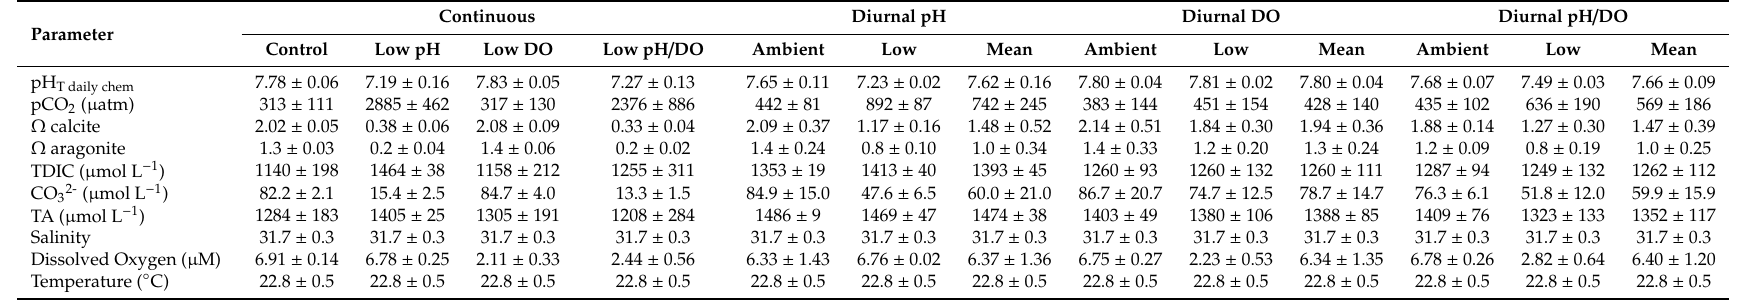
Table 4. Mean ( ± standard deviation) pH, pCO 2 , saturation states of calcite and aragonite, total dissolved inorganic carbon (TDIC), carbonate, total alkalinity (TA), salinity, dissolved oxygen, and temperature for the Menidia beryllina seven treatment diurnal acidification and hypoxia experiments. Parameter